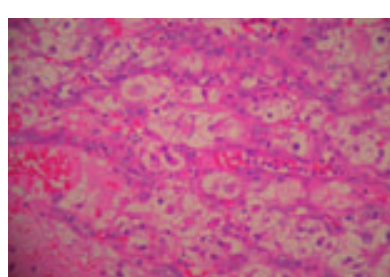
Figure 2. Computerized tomography scan of the abdomen showing a 7 cm area of enhancement in the left lower pole of the kidney (arrow) consistent with renal clear cell carcinoma.